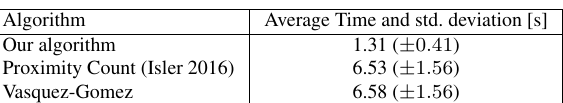
Figure 11. Map uncertainty versus elapsed time. Table 2. Average time and std. deviation to compute a viewpoint with the different algorithms.